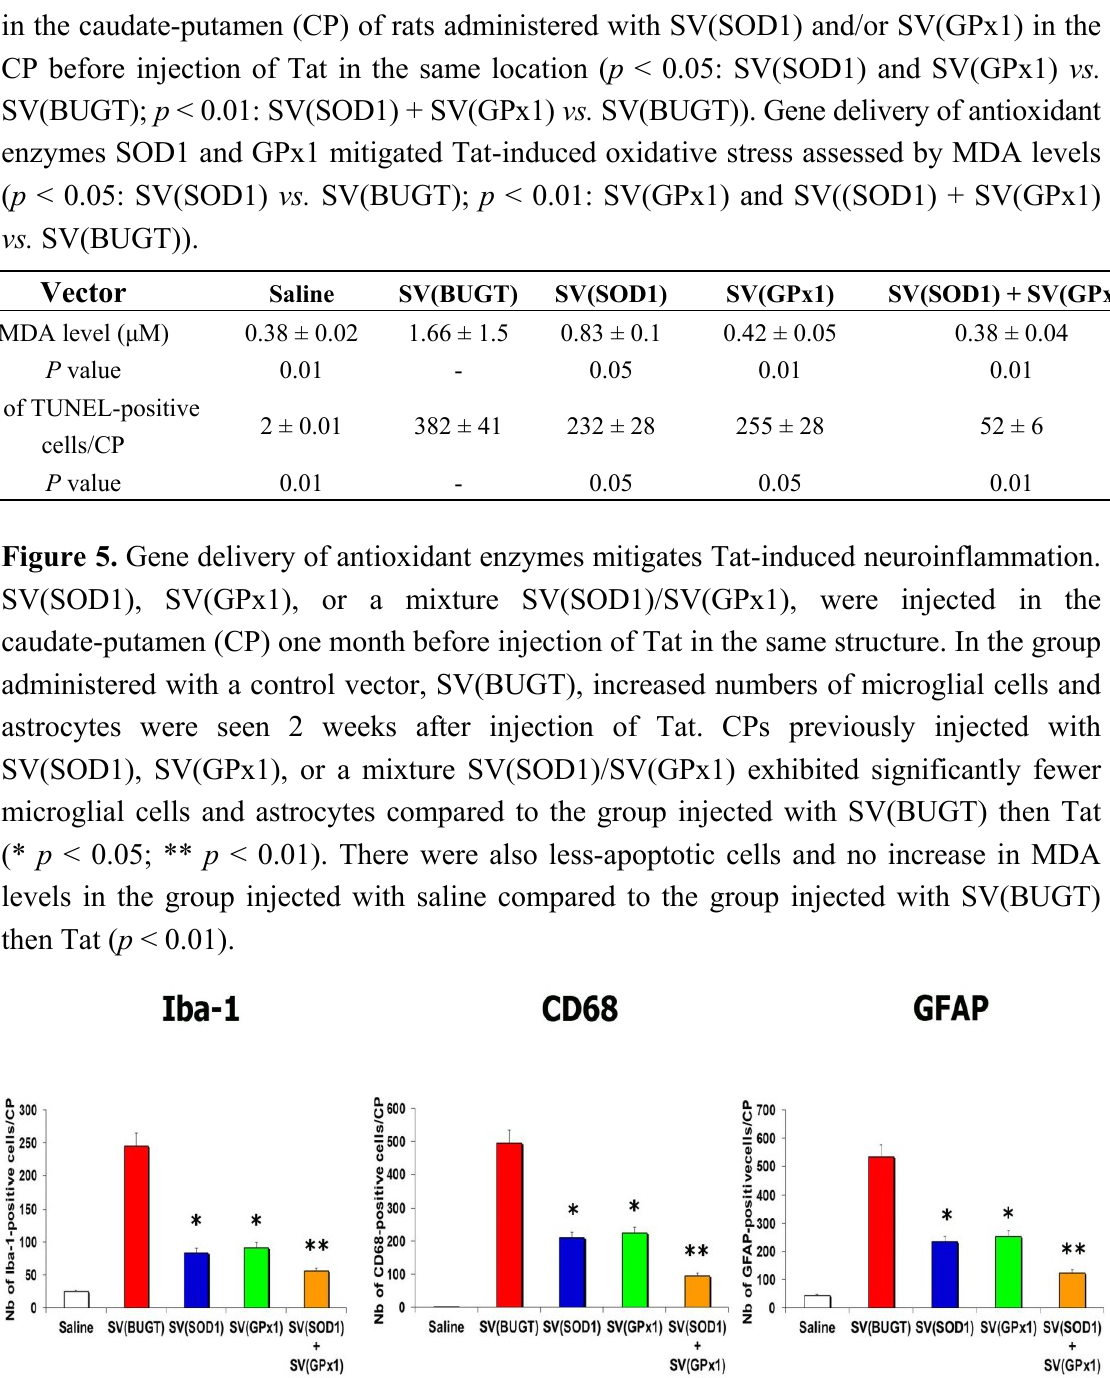
Table 2. Table showing the effect of gene delivery of antioxidant enzymes SOD1 and GPx1 on oxidative stress and apoptosis induced by Tat. Less apoptotic cells were observed